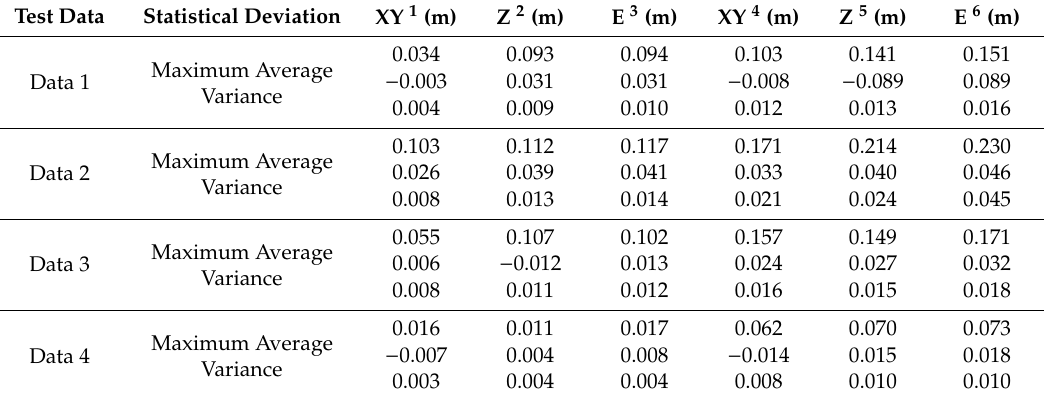
Table 3. Comparison between the recovered center of emission of laser and the true